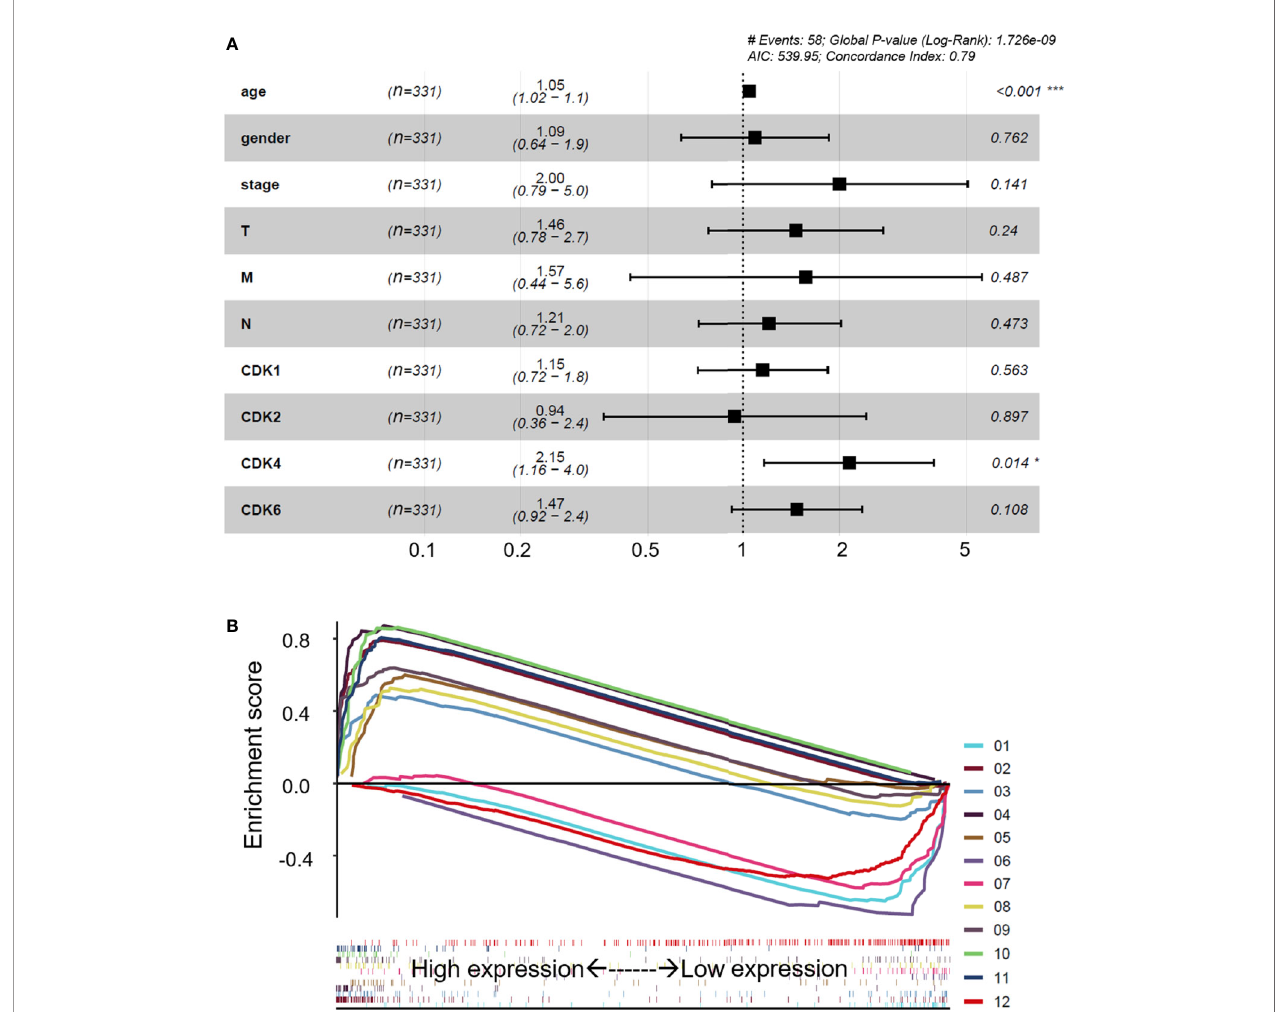
FIGURE 2 | Multivariate Cox analyses and potential regulatory signaling pathways of CDKs. (A) Multivariate Cox analyses of clinical features and CDKs. (B) Related regulatory pathway prediction of CDKs based on GSEA. The pathways in the fi gure are as follows: 1, basal cell carcinoma; 2, cell cycle; 3, colorectal cancer; 4, DNA replication; 5, fatty acid metabolism; 6, glycosaminoglycan biosynthesis of chondroitin sulfate; 7, hedgehog signaling pathway; 8, NOD-like receptor signaling pathway; 9, p53 signaling pathway; 10, protein export; 11, RNA degradation; 12, neuroactive ligand receptor interaction. The enrichment processes of all the related pathways are shown below as bar codes. *p < 0.05 or ***p < 0.001 in the multivariate Cox analyses were considered statistically signi fi